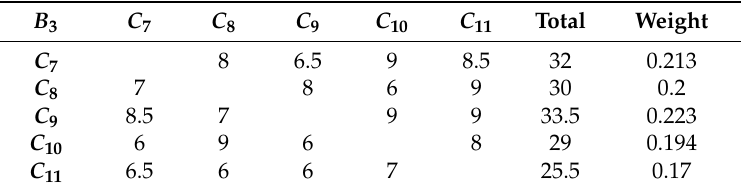
Table A4. Judgment matrix of C 7 – C 11 .